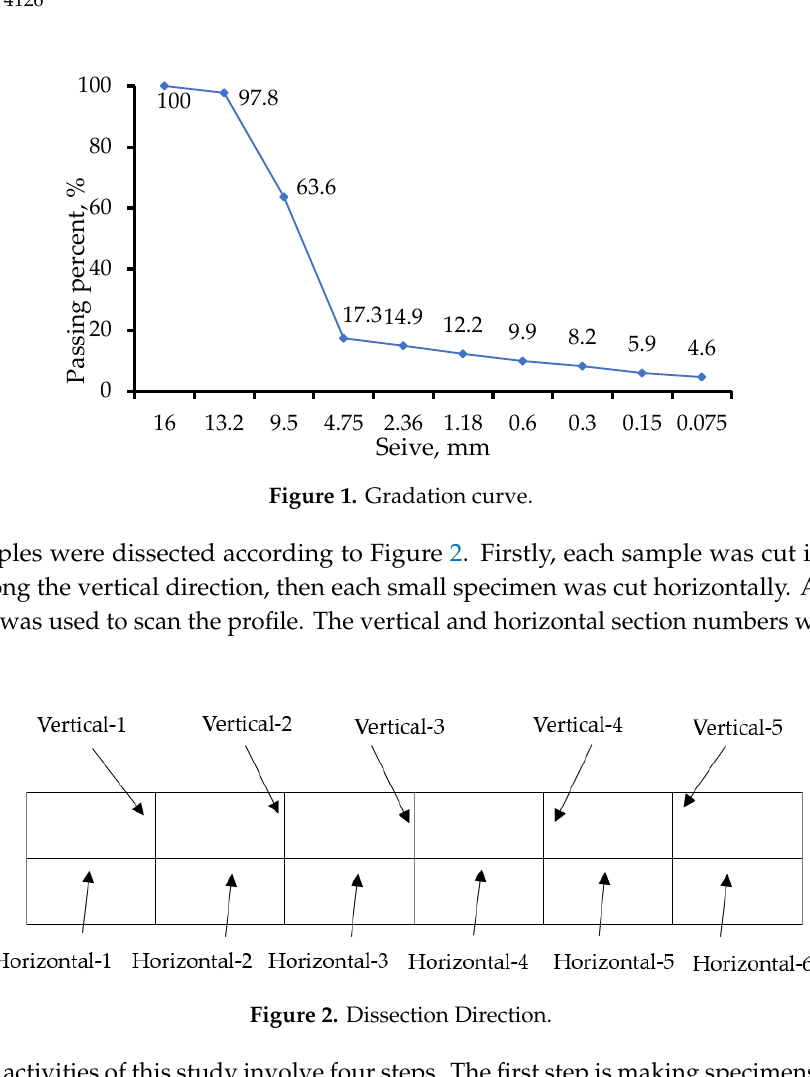
Figure 3. Initial Digital Image .